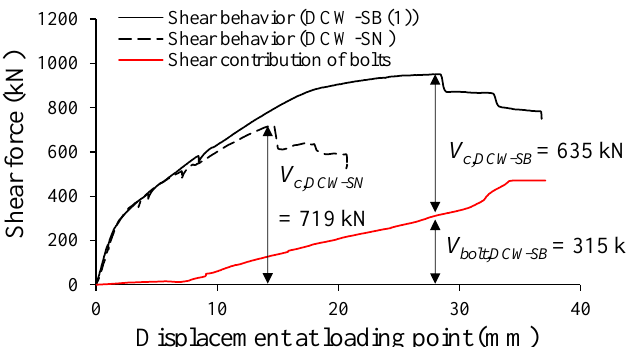
10 of 20 ( e ) Figure 7. Shear behavior of the DCW-S specimen series: ( a ) DCW-SN specimen; ( b ) DCW-SB(1) specimen; ( c ) DCW-SB(2) specimen; ( d ) measured end slip (DCW-SN specimen); ( e ) measured bolt strains (DCW-SB(1) specimen). For the DCW-SB(1) specimen in which bolts were placed in the shear span, as shown in Figure 7b, flexural cracking occurred at a shear force of about 160 kN, and shear crack- ing was observed at a shear force of 389 kN. In the upper surface of the bottom flange, horizontal cracking toward the support occurred at a shear force of 607 kN, as shown in the picture in Figure 7b, and the stiffness of the specimen began to decrease rapidly, start- ing from a shear force of approximately 900 kN. Finally, after reaching the maximum shear force of 950 kN, the DCW-SB(1) specimen underwent failure as the load gradually decreased. In the DCW-SB(2) specimen with the same details as the DCW-SB(1) specimen, the first flexural cracking was observed at a shear force of 158 kN, and inclined cracking occurred at a shear force of 467 kN, as shown in Figure 7c. After that, the DCW-SB(2) specimen showed behavior that was almost similar to that of the DCW-SB(1) specimen and failed in shear at a shear force of 947 kN. It should be noted that in the DCW-SB(1) and (2) specimens, shear cracks that occurred in the lower PC panel propagated to the upper PC panel, unlike in the DCW-SN specimen, because the integrity of the upper and lower PC panels was improved due to the bolts placed in the shear span. Consequently, the shear strengths of the DCW-SB(1) and (2) specimens increased by about 32% compared with those of the DCW-SN specimen because of the shear contribution of the bolts used for assembling the PC panels. Figure 7e shows the axial strains measured from the gauges attached to the bolts